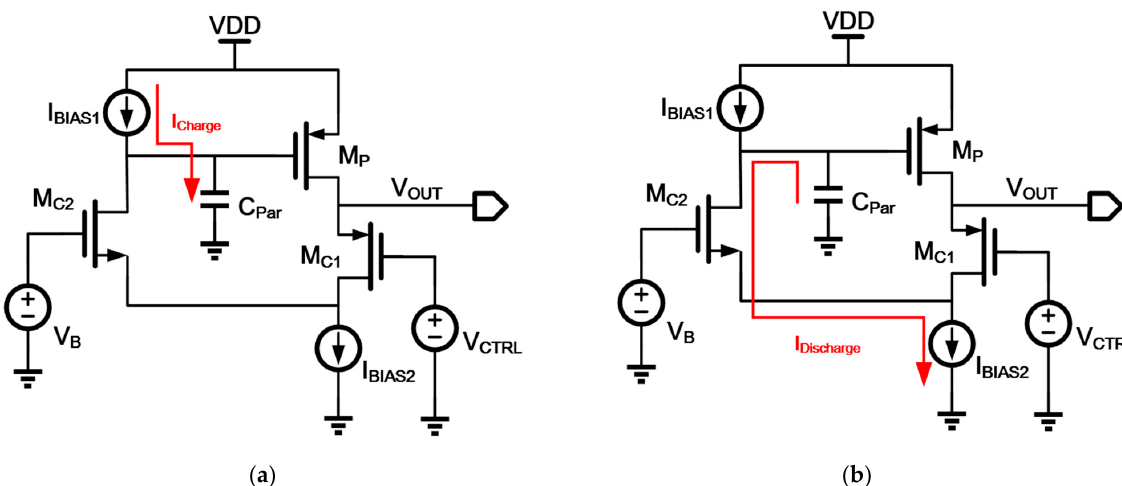
Figure 1. Large-signal response of FVF-based LDO ( a ) charge ( b ) discharge.